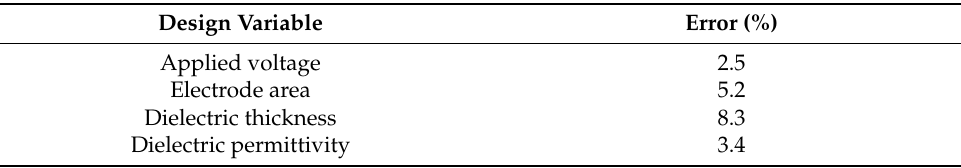
Table 3. Modeling and analysis data comparison verification: error.